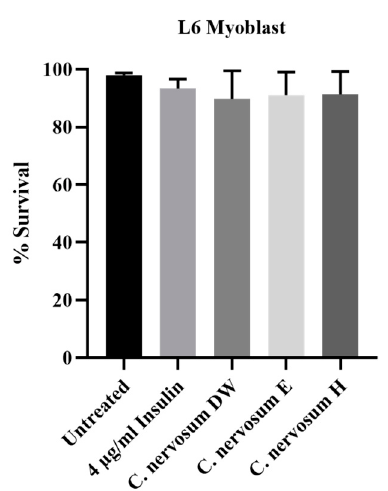
Figure 2. The cytotoxicity effect of water, ethanol, and hexane extracts of C. nervosum at concentration of 1 mg/mL on L6 myoblasts after 72 h exposure assessed by MTT assay. Data are mean ± SD of three independent experiments. The control was cells not treated with extracts. No significant difference relative to the untreated control was noted.